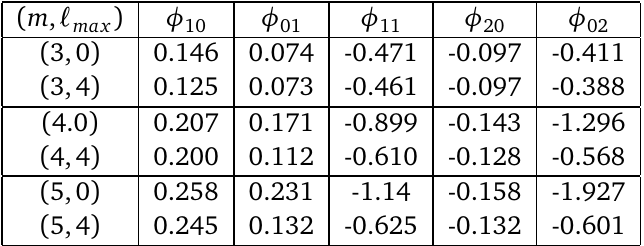
Table 2: φ ’s from s-channel representation, keeping only ε ( c pq